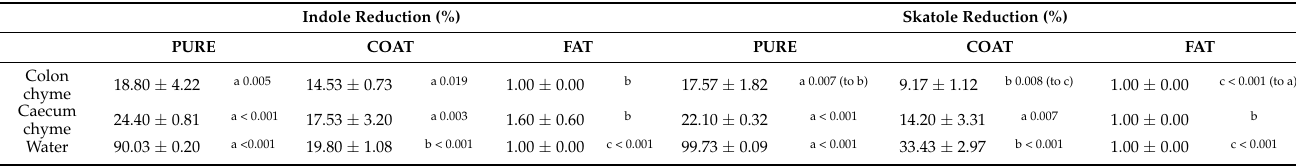
Table 3. Indole and skatole reduction (%) in vitro (mean ± standard error of the mean) by pure charcoal (2% w/w) (PURE), coated charcoal (4% w/w) (COAT) and fat (2% w/w) (n = 3). Indole Reduction (%) Skatole Reduction (%) PURE COAT FAT PURE COAT FAT